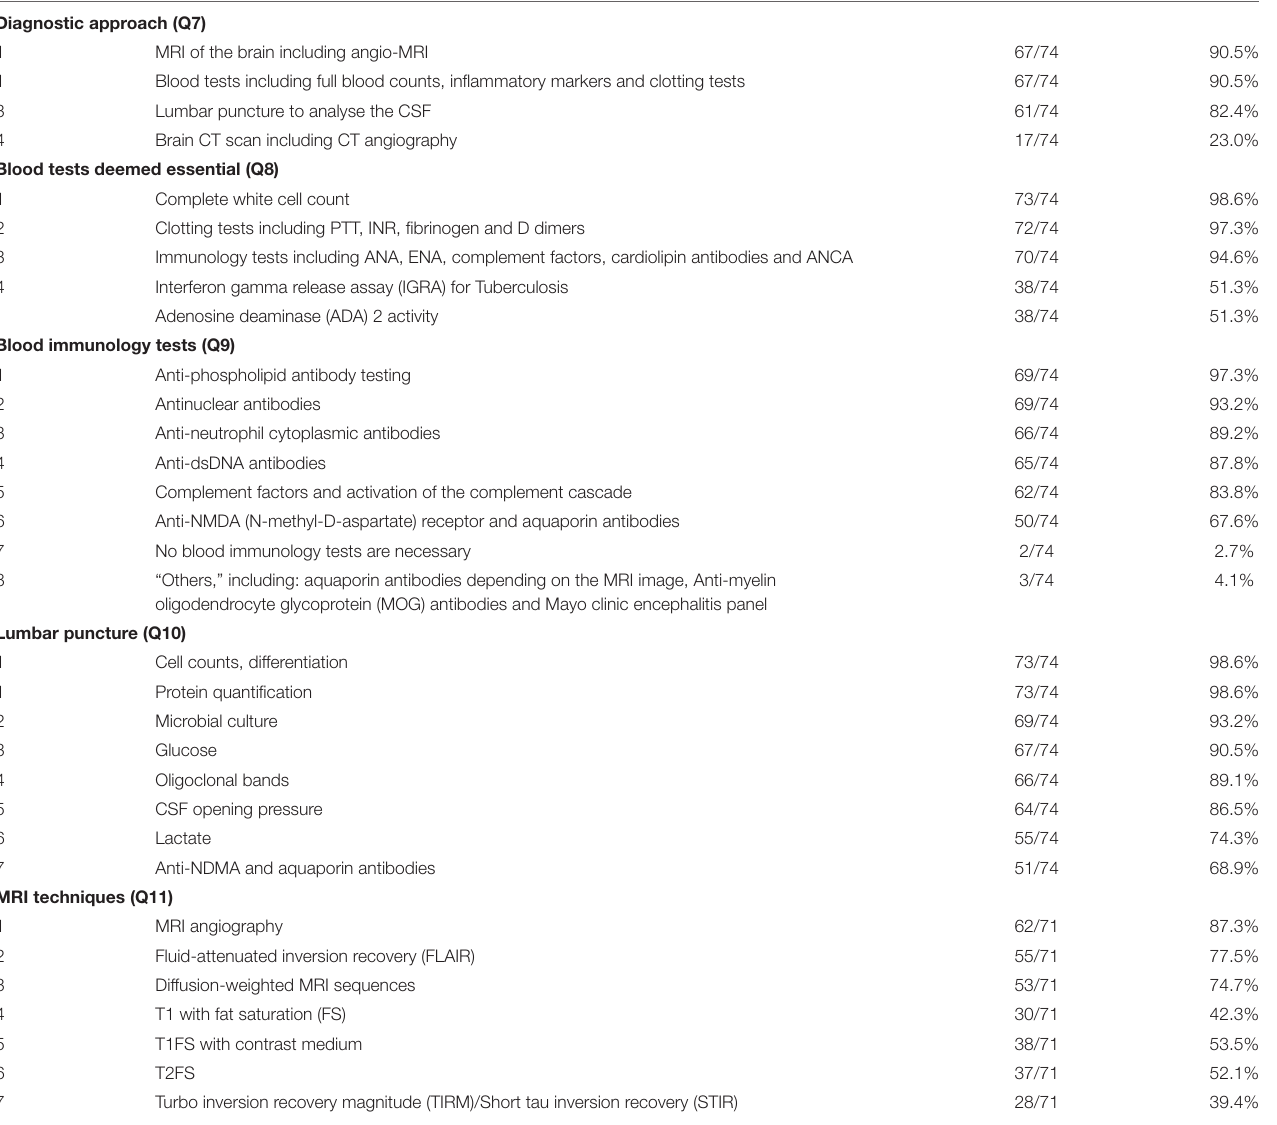
TABLE 2 | Diagnostic approach in case 1. Diagnostic approach